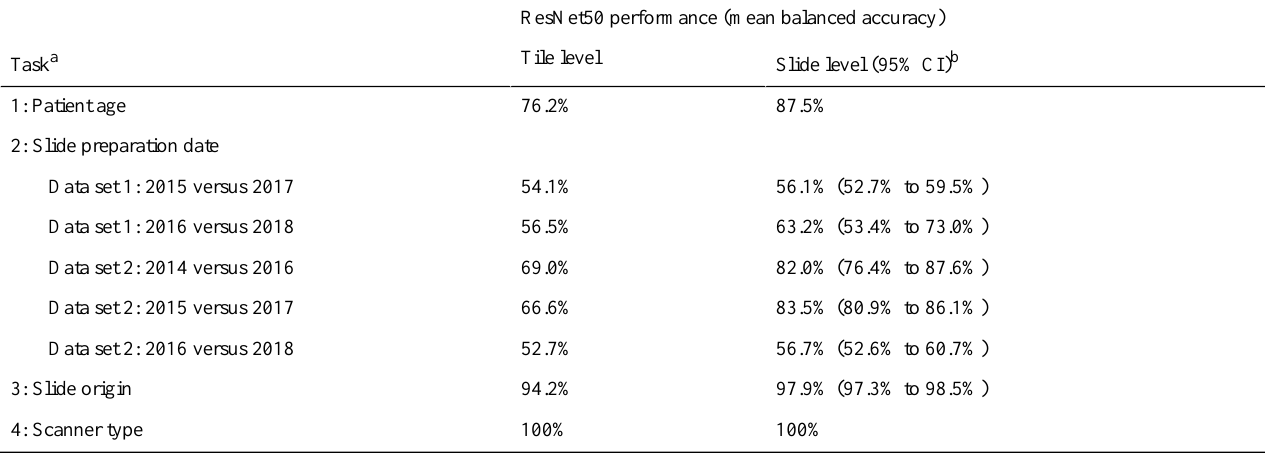
Table 2. Overall mean performance of each task’s classifiers measured using mean balanced accuracy and evaluated on tile level and slide level. ResNet50 performance (mean balanced